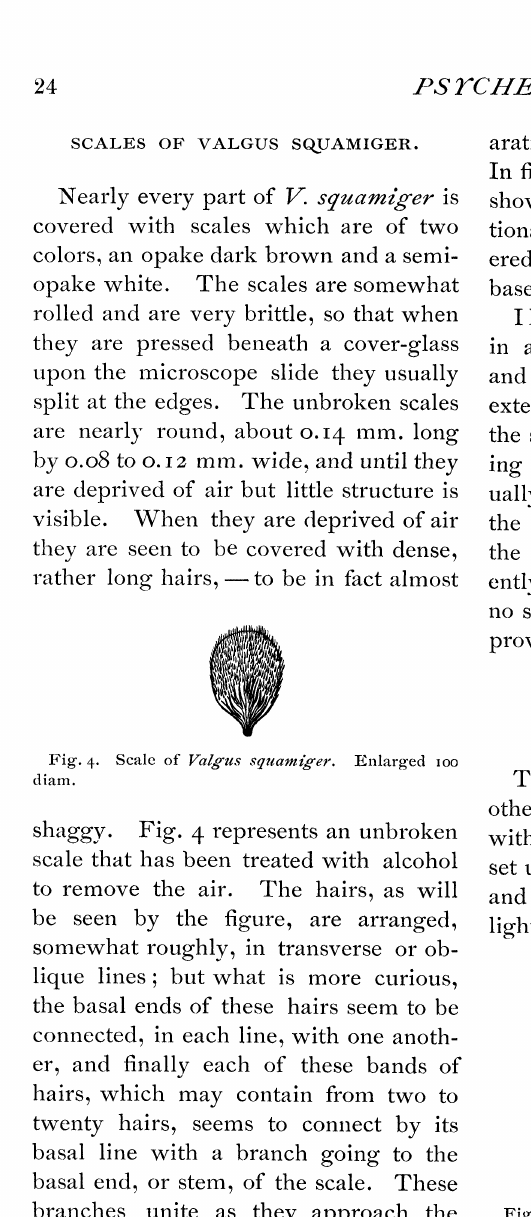
Fig. 5. Hair of 29siloptera drummondi. Enlarged Ioo